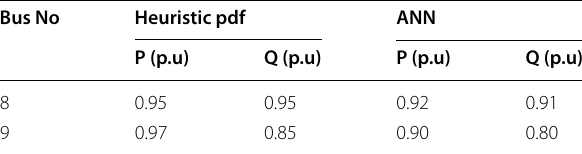
Table 13 DG size comparison under ANN and heuristic pdf at buses 8 and 9